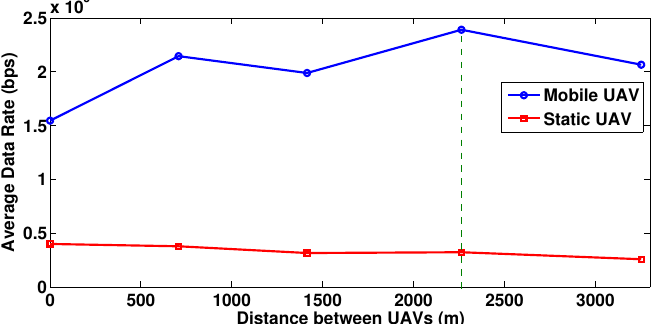
Figure 5. Average user data rate for mobile and static UAV for increasing distance between the